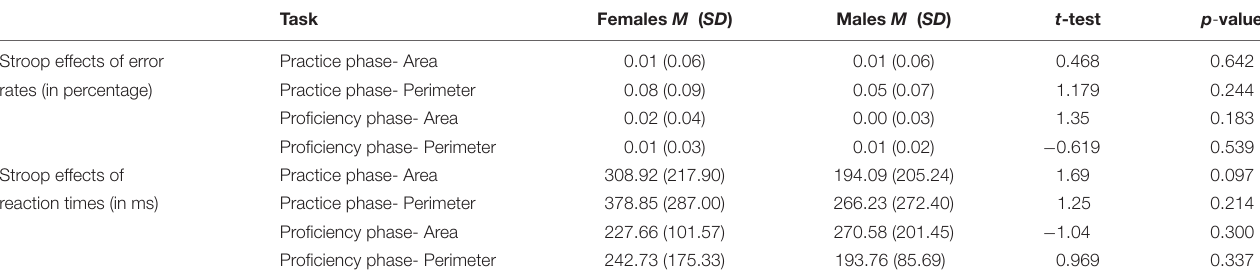
TABLE 2 | Mean scores and gender differences in area and perimeter tasks across different exposure phases.